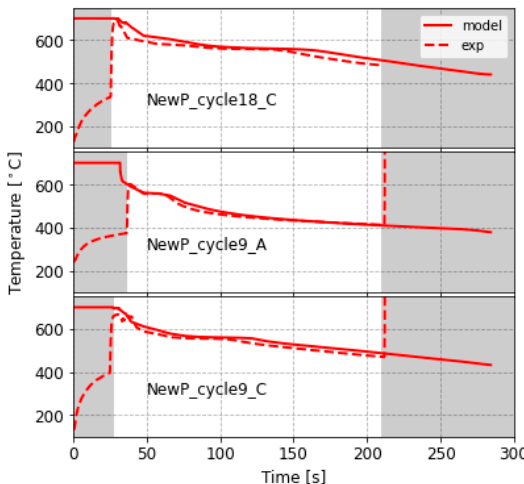
Metals 2020 , 10 , x FOR PEER REVIEW Figure 22. Error between the model and measured data. Figure 22. Error between the model and measured data.